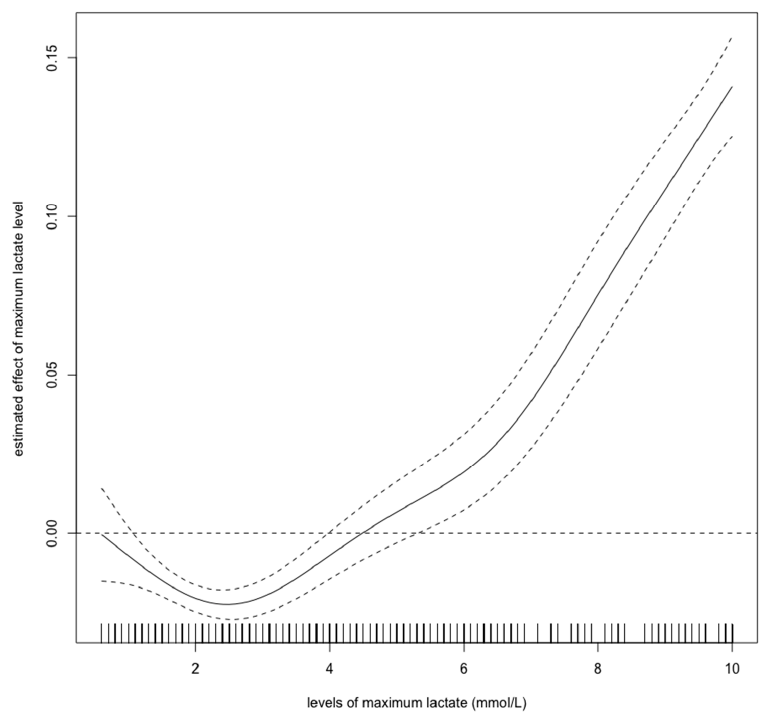
Figure 2. Nonlinear relationship between the lactate level (mmol/L) and 28-day mortality in critically ill children with acute kidney injury. The curve: estimated spline function in log odds ratio on the effect of the lactate level. The dotted lines: 95% confidence interval.